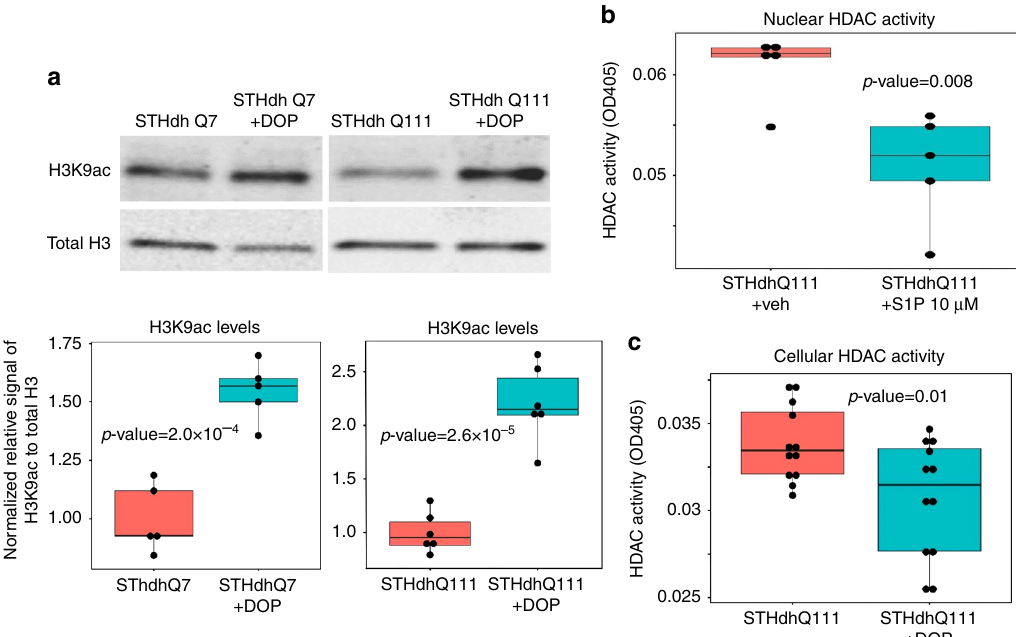
Fig. 8 Inhibiting the SPL enzyme and increasing S1P levels enhance H3K9 acetylation and decrease HDAC activity. a Western blot experiments show a signi fi cant increase in H3K9ac levels in STHdh Q111 cells ( p = 2.0 × 10 − 4 , two-tailed t -test) and STHdh Q7 cells ( p = 2.6 × 10 − 5 , two-tailed t -test) after treatment with DOP compared to untreated cells. b Incubation of nuclear extracts from STHdh Q111 cells with 10 µ M S1P diminishes HDAC activity ( p = 0.008, two-tailed t -test). HDAC activity is expressed as optical density at 405 nm (OD405). c Treating STHdh Q111 cells with 4 mM DOP signi fi cantly decreases HDAC activity (OD405) ( p = 0.01, two-tailed t -test). The boxplots show the distribution of the data, while each dot shows a data point corresponding to a biological replicate. The fi rst and the third quartiles of the data are represented by the top and the bottoms of respective boxes and the median (second quartile value) is displayed as a horizontal line within the